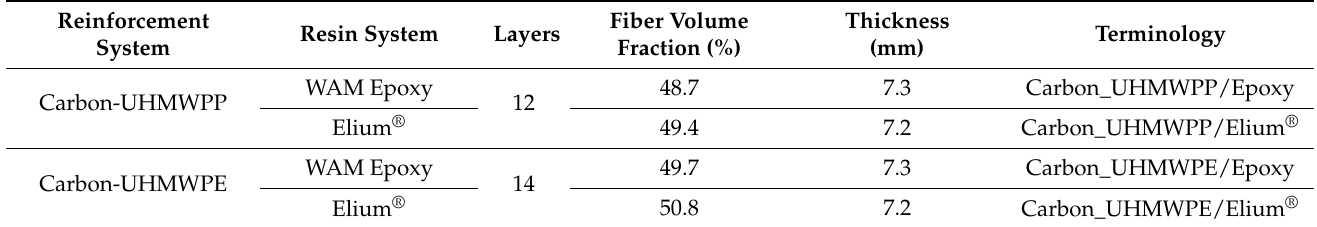
Table 1. Manufactured laminates configurations with their thickness, fiber volume fraction, and nomenclature used in current